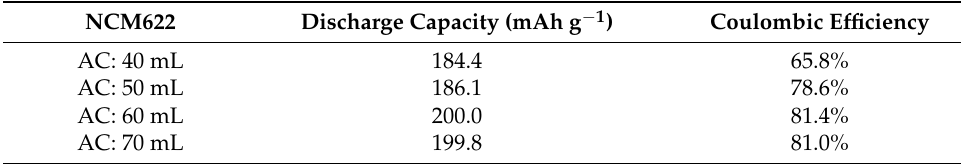
Table 5. Cycling capability of NCM622 different ammonia content.